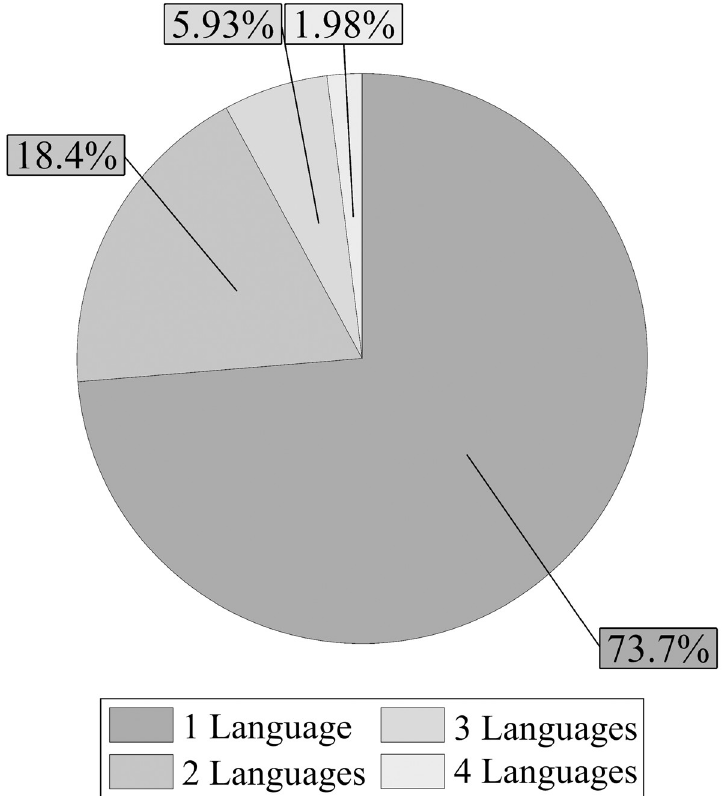
Fig 3. Relative frequency of passively used languages (native and foreign). A total of 709 participants reported the passive use of one language; 177 reported the passive use of two; 57 the passive use of three; and 19 reported the passive use of four